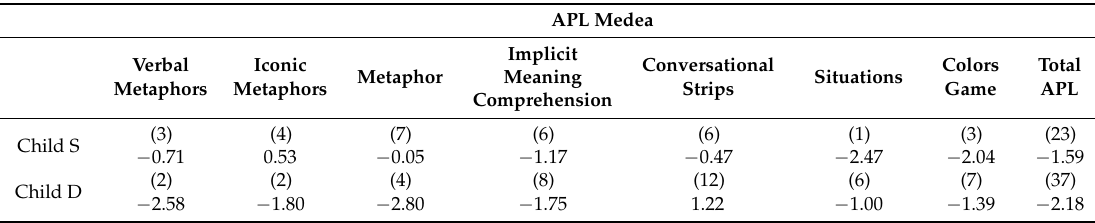
Table 2. APL Medea subtests and total test. Raw scores and z